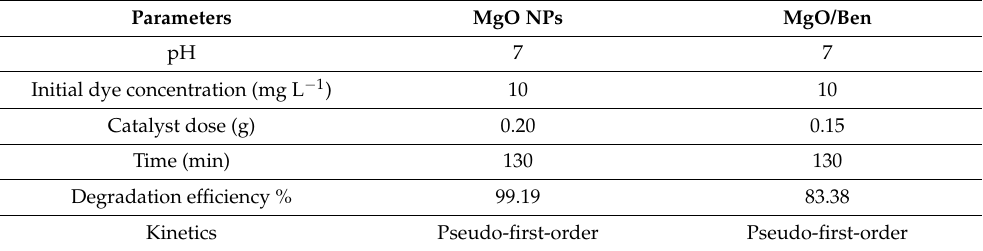
Table 6. The optimum conditions for photocatalytic degradation of crystal